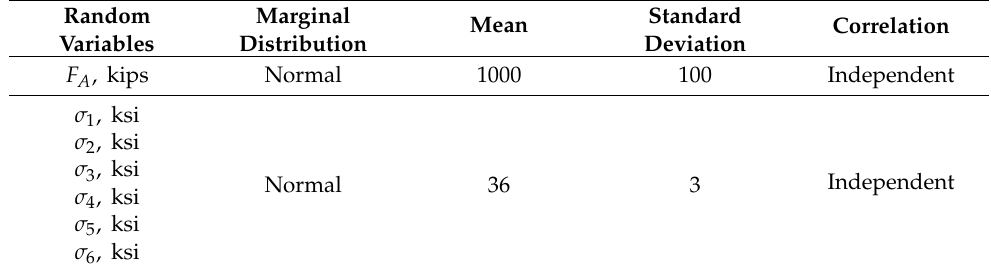
Table 7. Description of random variables for the truss optimization problem.